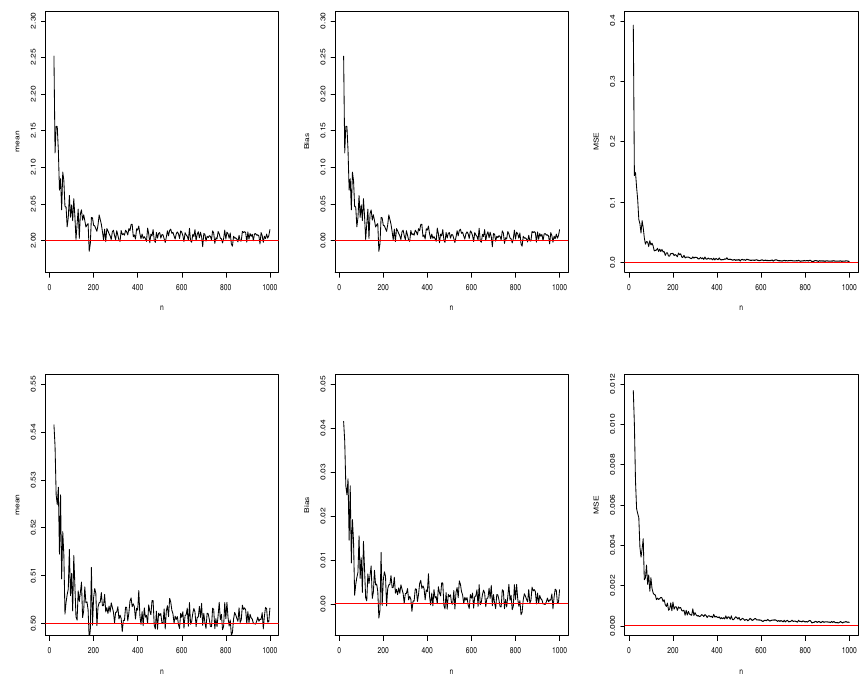
Figure 10. The results of the α ( top ) and β ( bottom ) parameters for the simulation-IV.